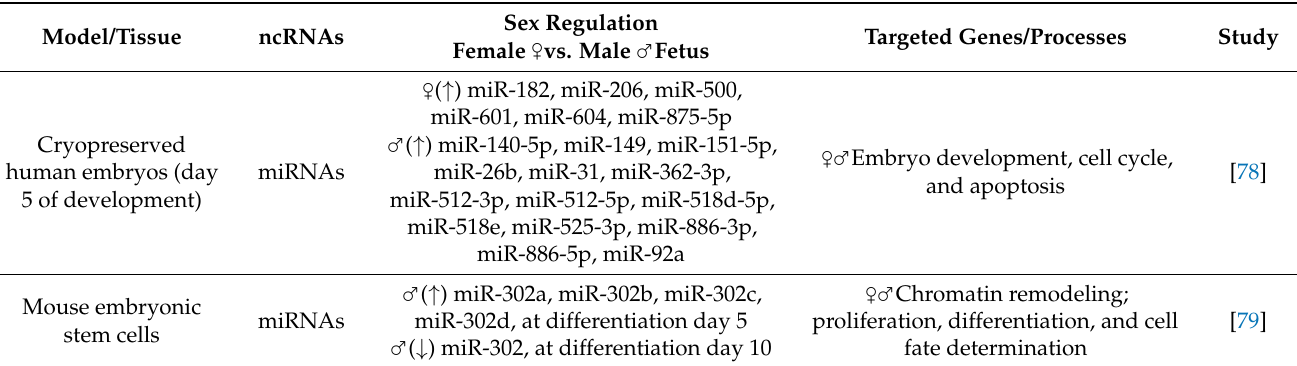
Table 2. Sex-specific ncRNAs expression in fetal